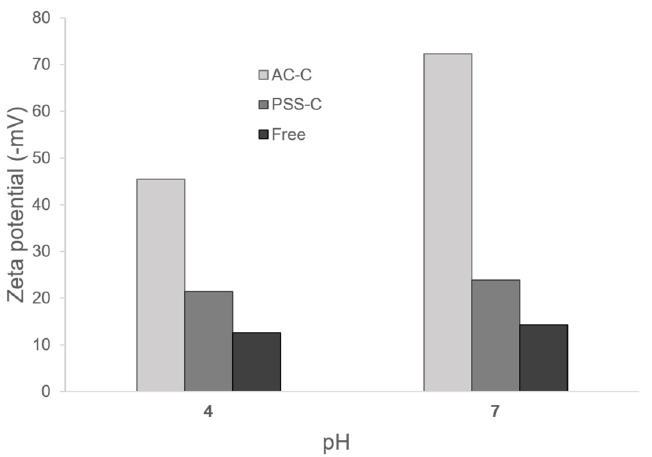
Figure 3. Zeta potential measurements of AC-C, PSS-C, and free laccase at pH 4.0 and 7.0. Colloidal stability for AC-C increased by about threefold and fivefold with respect to free laccase at acid and neutral pH values, respectively.